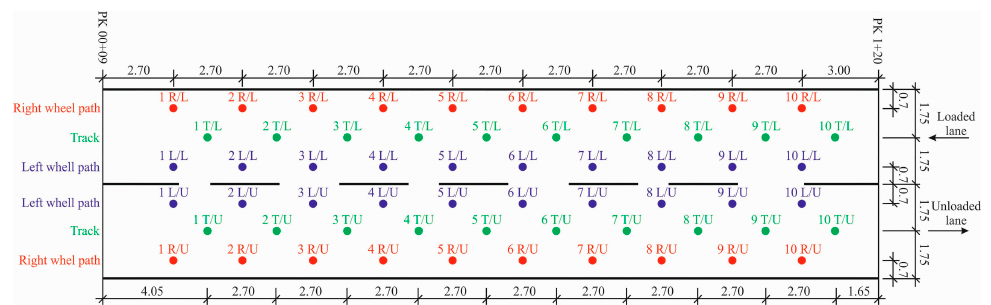
Figure 2. The layout of points of measured deflection in the tested PS No 4 (where: R/L—right wheel path of the loaded lane, T/L—track of the loaded lane, L/L—left wheel path of the loaded lane, R/U—right wheel path of the unloaded lane, T/U—track of the unloaded lane and L/U—left wheel path of the unloaded lane. Distances between measuring points are given in meters (m) Table 2. Date of deflection measurements in